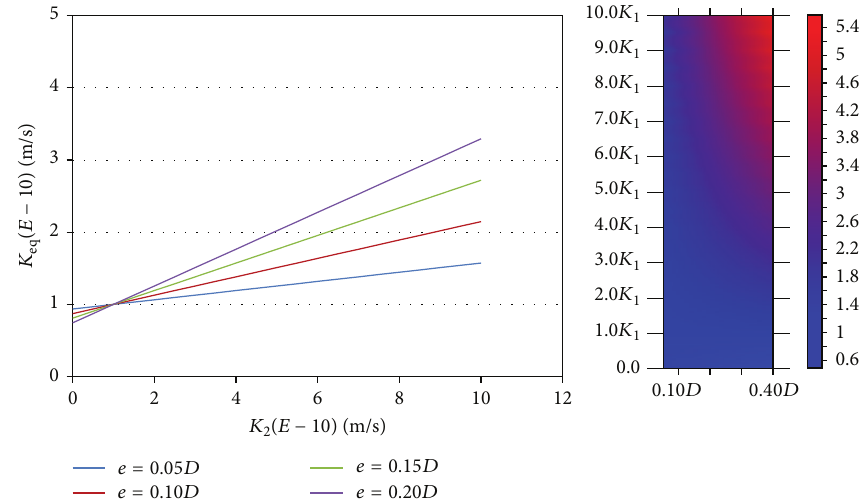
Figure 4: Equivalent water permeability with varying 𝐾 2 and 𝑒 .